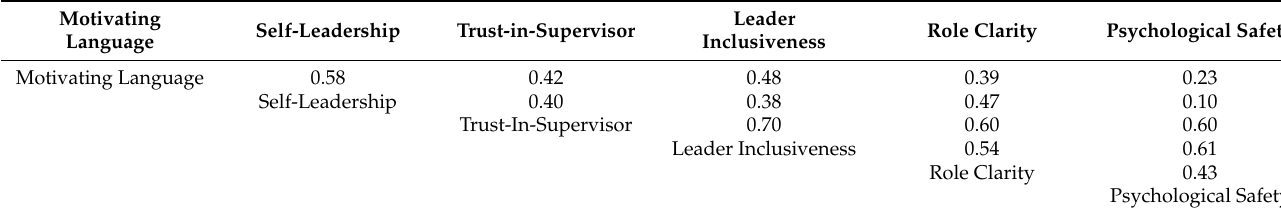
Table 3. Study Variable Correlations.